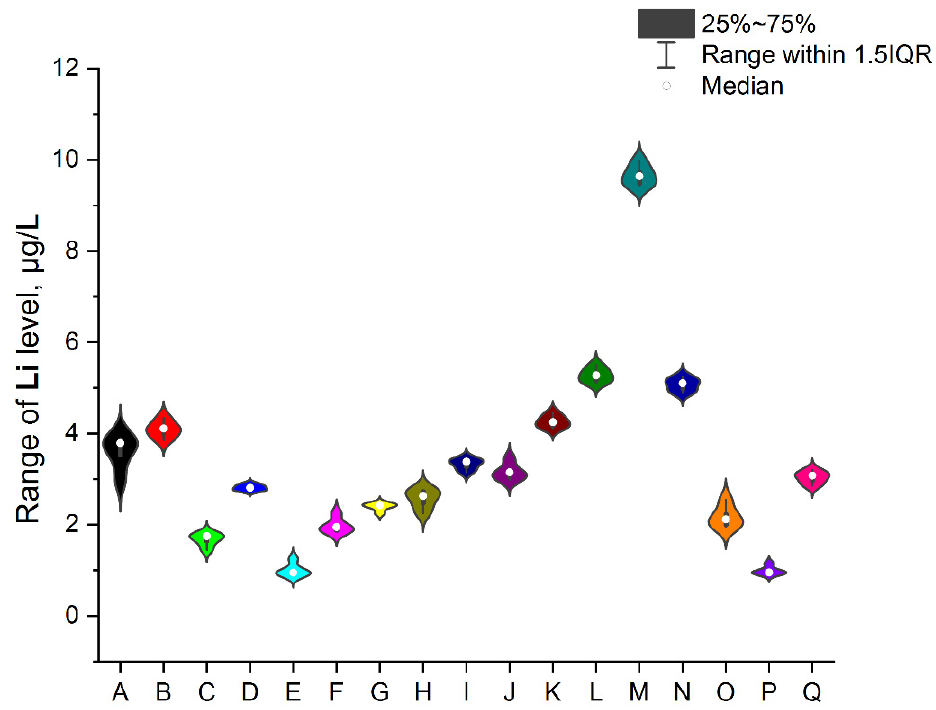
Figure 4. The plot as a violin with the box for the Li level (µg/L) in the examined products (A–Q).